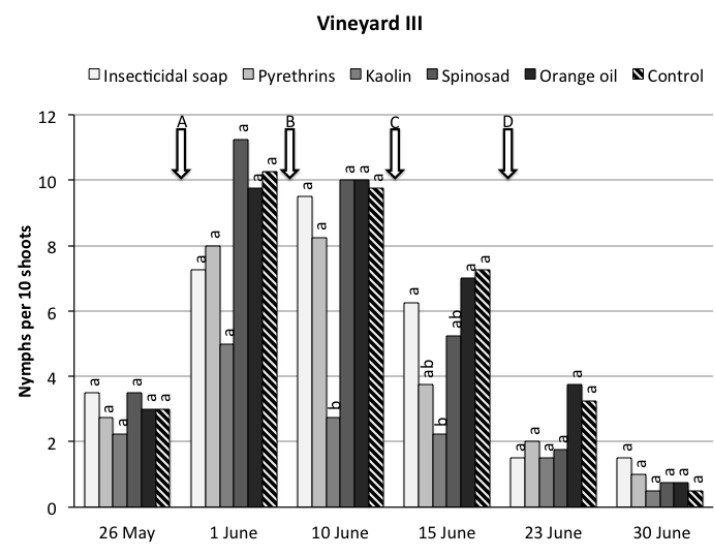
Figure 3. Scaphoideus titanus nymphs recorded on grapevine suckers during the sampling period in vineyard III under six different treatments. Within the same date, different small letters above bars indicate significant differences according to t -tests on the least square means with Bonferroni correction (α = 0.05). The arrows indicate the application timings of application of the natural products.